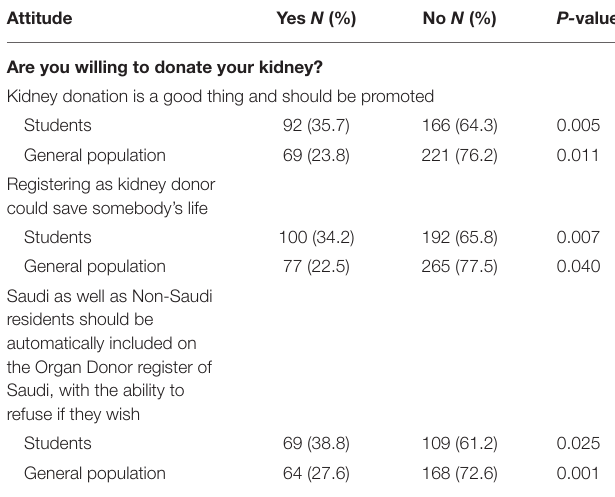
TABLE 7 | Correlation between attitude and